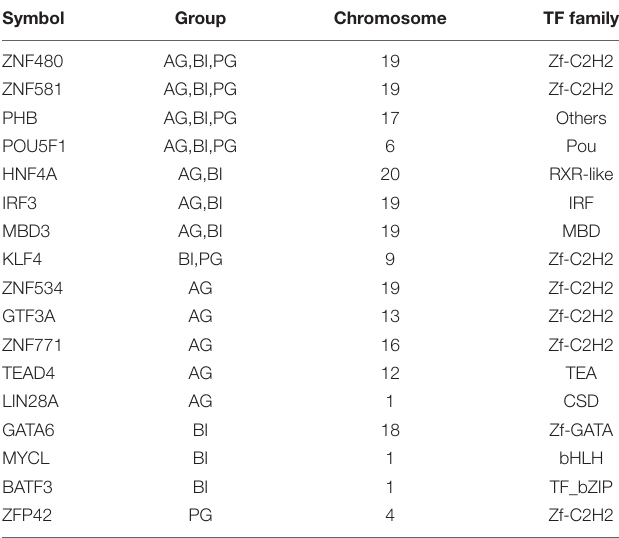
TABLE 1 | Detailed information of detected hub